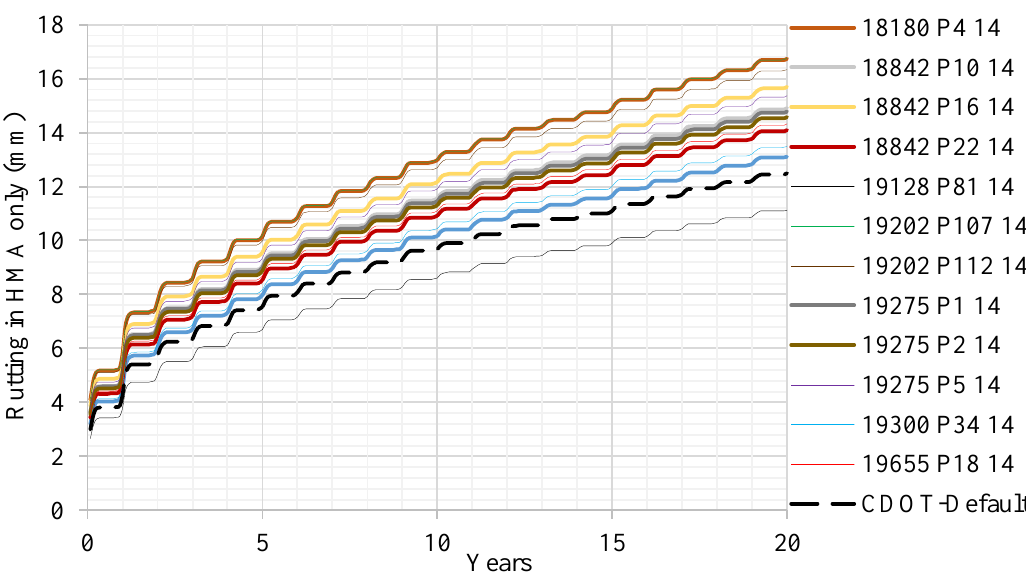
Figure 4. Rutting in asphalt layer due to AADTT = 7000 by SX (100) PG 64-22 mix. Bottom-up Fatigue Cracking: Figure 5 shows the bottom-up fatigue cracking of the trial pavement with the service life of the pavement for AADTT = 7000. It shows that the prediction of bottom-up fatigue cracking by the CDOT-default mix data (except for 19,128 P81 14) is the lowest. This means that the CDOT-default dynamic modulus data for the PG 62-22 binder predicts lower bottom-up fatigue cracking compared to that of the actual tested dynamic modulus (except for 19,128 P81 14). The assumed threshold of 35% of the lane area show that the mixes reach the threshold between three and four years, which is very close to each other. The statistical analysis shows that none of the mix listed in Figure 5 is within the 95% CI boundaries. Figure 5. Bottom-up fatigue cracking due to AADTT = 7000 by SX (100) PG 64-22 mix. Top-down Longitudinal Cracking: Figure 6 shows the top-down longitudinal cracking of the trial pavement with the service life of the pavement for AADTT = 7000. It shows that the prediction